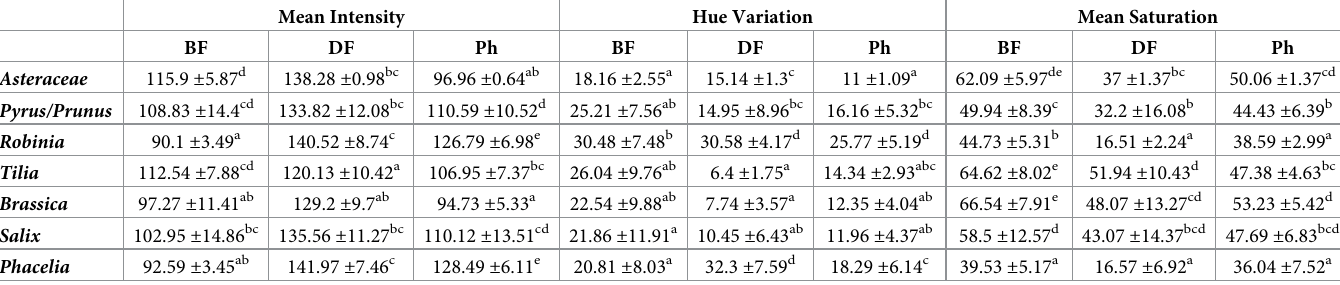
Table 10. Intensity and HSB colour descriptors of pollen grains.